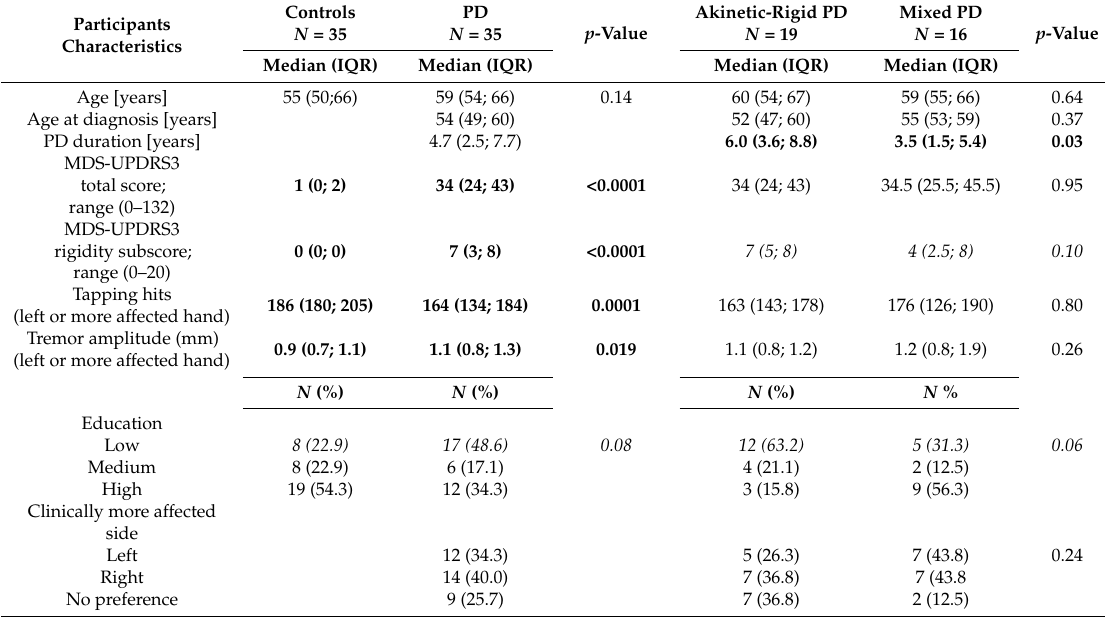
Table 1. Demographics and clinical data of male patients with Parkinson disease and of controls.